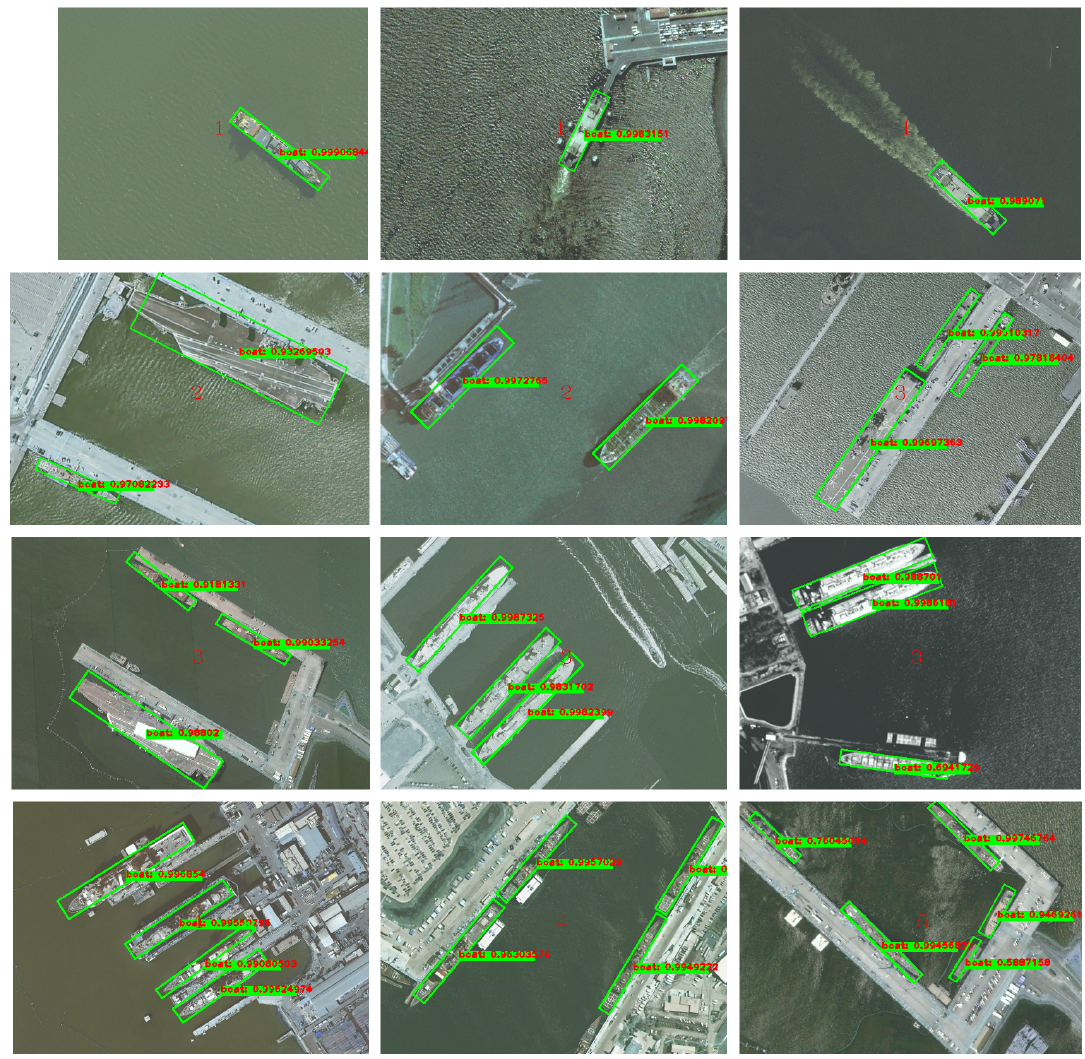
Figure 13. Visualization of detected ships with the proposed method on HRSC2016